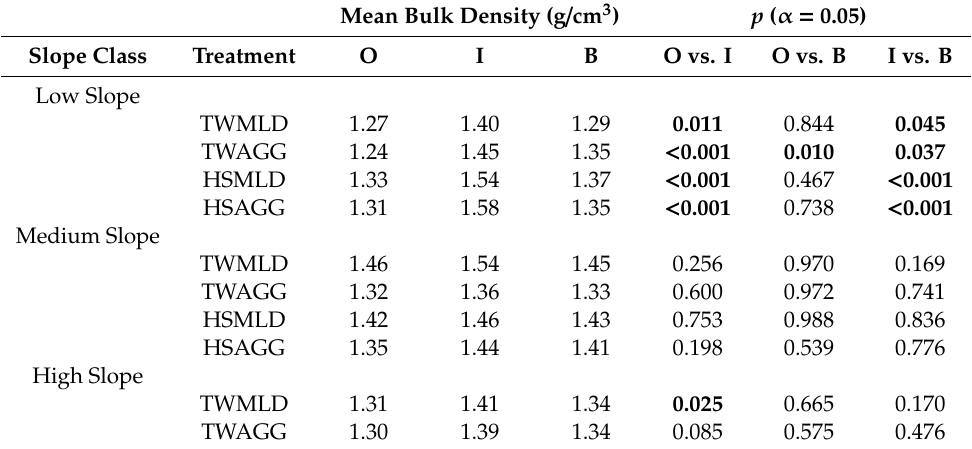
Table 1. O ff -track (O), in-track (I), and between-track (B) means for all slope classes and treatments, and the p -values for each sampling location pairing. P -values in bold are significantly di ff erent at α = 0.05.